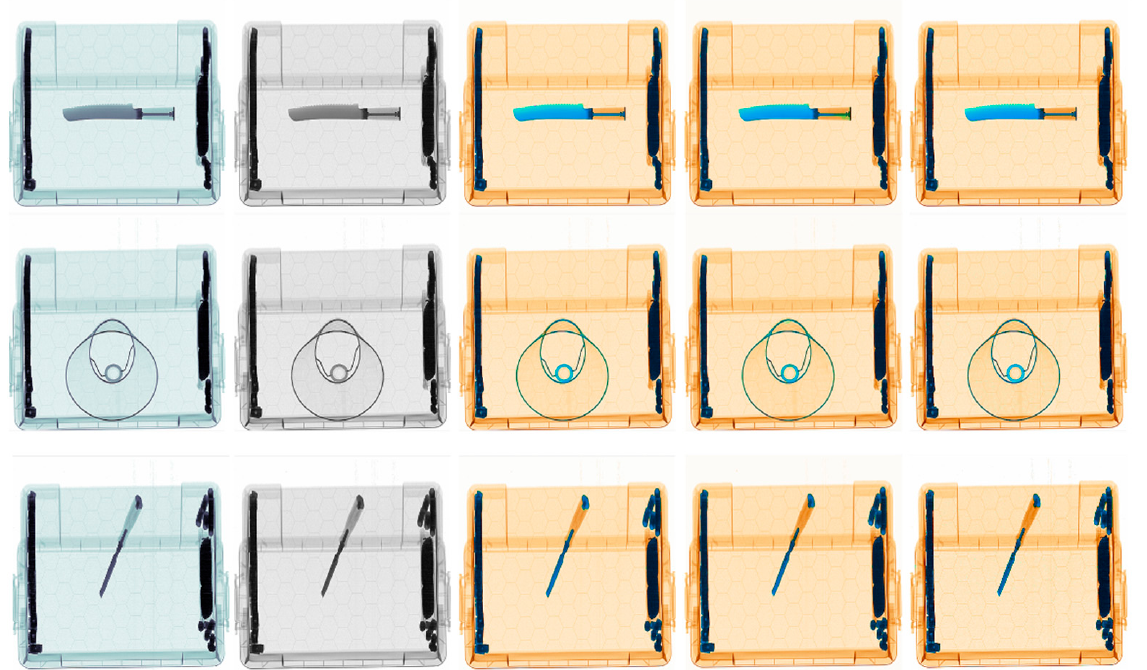
Figure 4. Example images of the ( a ) positive and ( b ) negative images from the SIXray dataset. Posi- tive images contain at least one of the prohibited objects, whereas negative images do not contain any prohibited objects. Table 4. Comparison of the colorization performance of the artificial image and raw-image-based models on the COMPASS-XP dataset in terms of PSNR, SSIM, and LPIPS. Input Image.